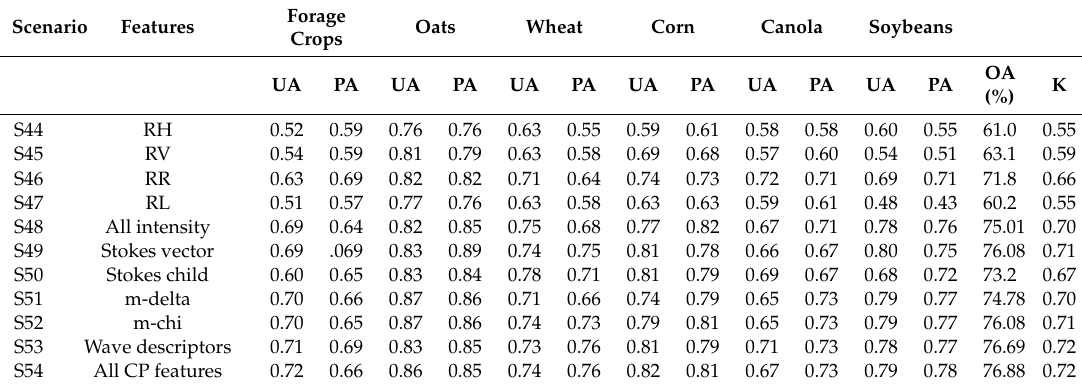
Table 9. Classification results obtained from extracted features from simulated CP SAR data at a noise floor (NF) of − 24